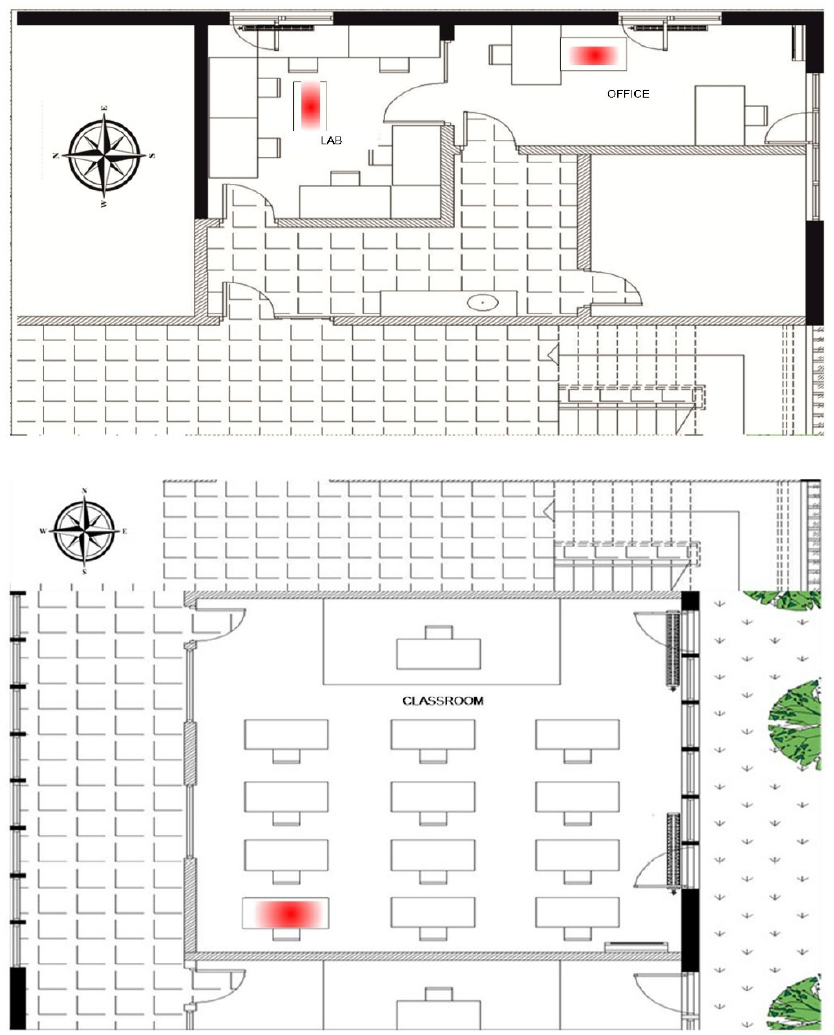
Figure 1. Floor plans of the Office, the computer center (Lab), and the small lecture room; the red rectangle is the location of the monitoring station. Table 1. Synopsis of the design of experiments.